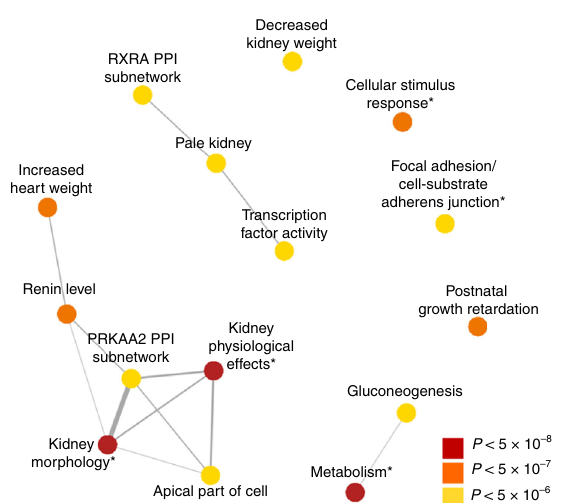
Fig. 1 Top gene sets prioritized from eGFR meta-analysis. DEPICT analysis of eGFR meta-analysis results identi fi es signi fi cant gene sets associated with kidney function and metabolic processes. The most signi fi cant gene sets are shown ( p -value < 3.46 × 10 − 6 , 0.05/14462 gene sets, out of 482 with FDR < 0.05), after collapsing highly overlapping gene sets. Overlap between gene sets is depicted by the width of connecting lines. *Denotes collapsed gene sets